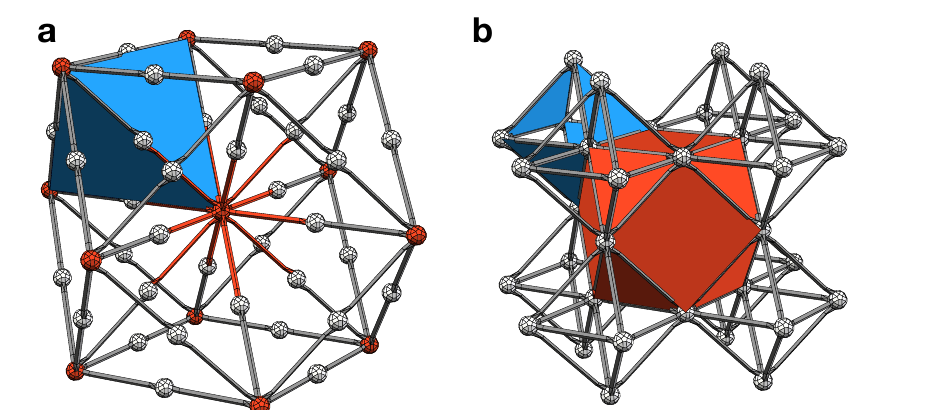
K rec obtained from K . Qubits are placed at vertices (white balls) and X - and Z - stabilizers are identi fi ed with volumes (red) and faces